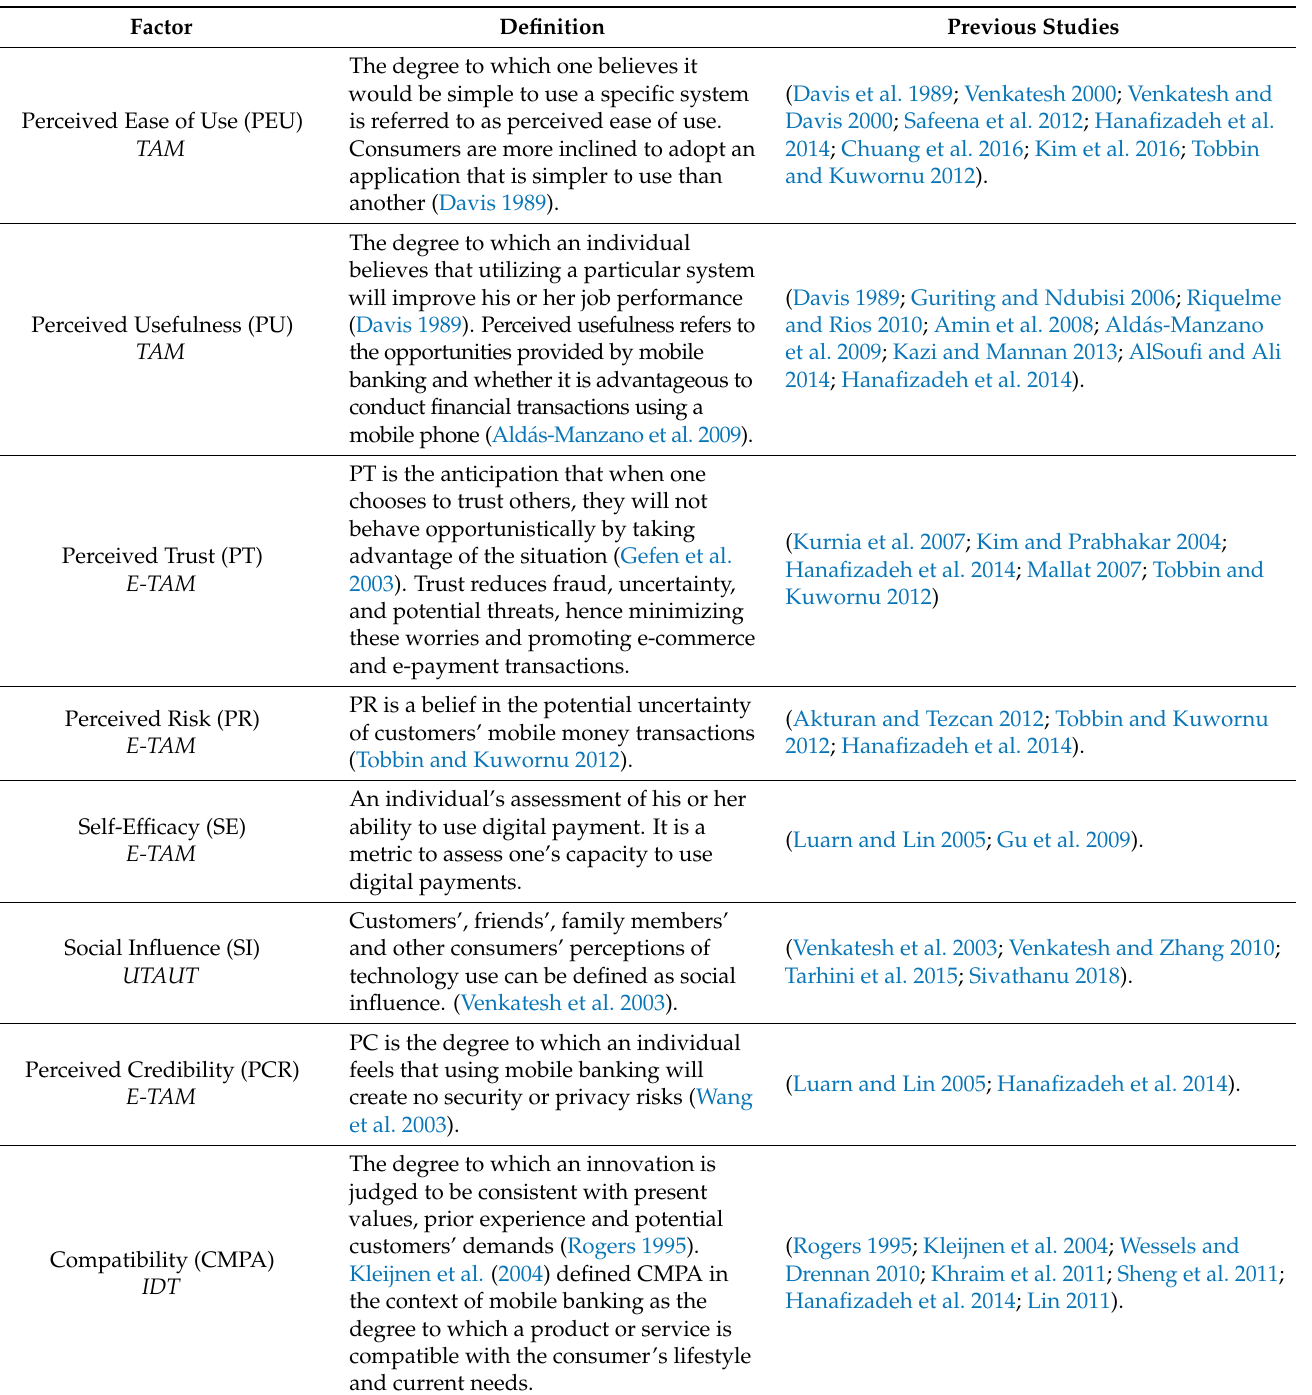
Table 2. Factors Affecting the Adoption of Online Payment